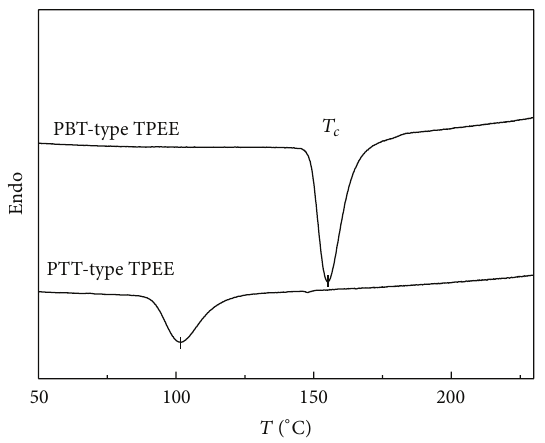
Figure 11: DSC crystallization curves of two copolymers.